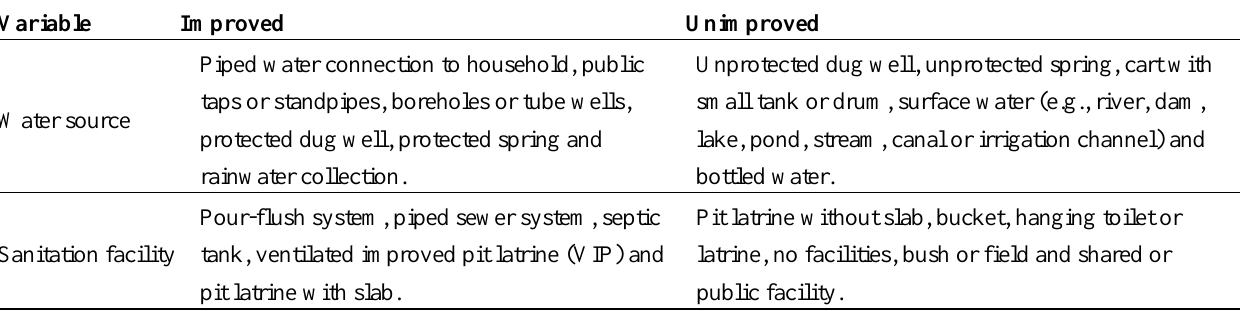
Table 1. Classification of water sources and sanitation facilities based on WHO/UNICEF guidelines